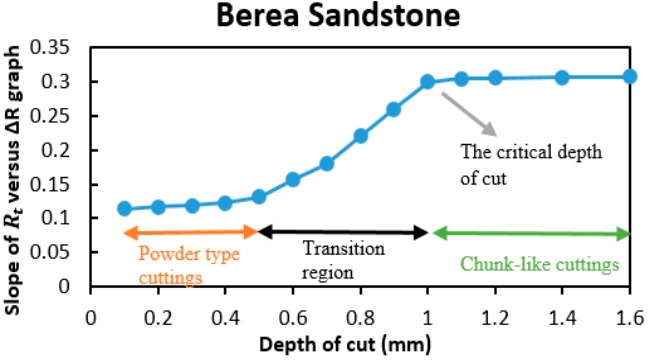
Figure 16. Evolution of R t versus ∆ R graph slope with the cutting depth for Berea sandstone.